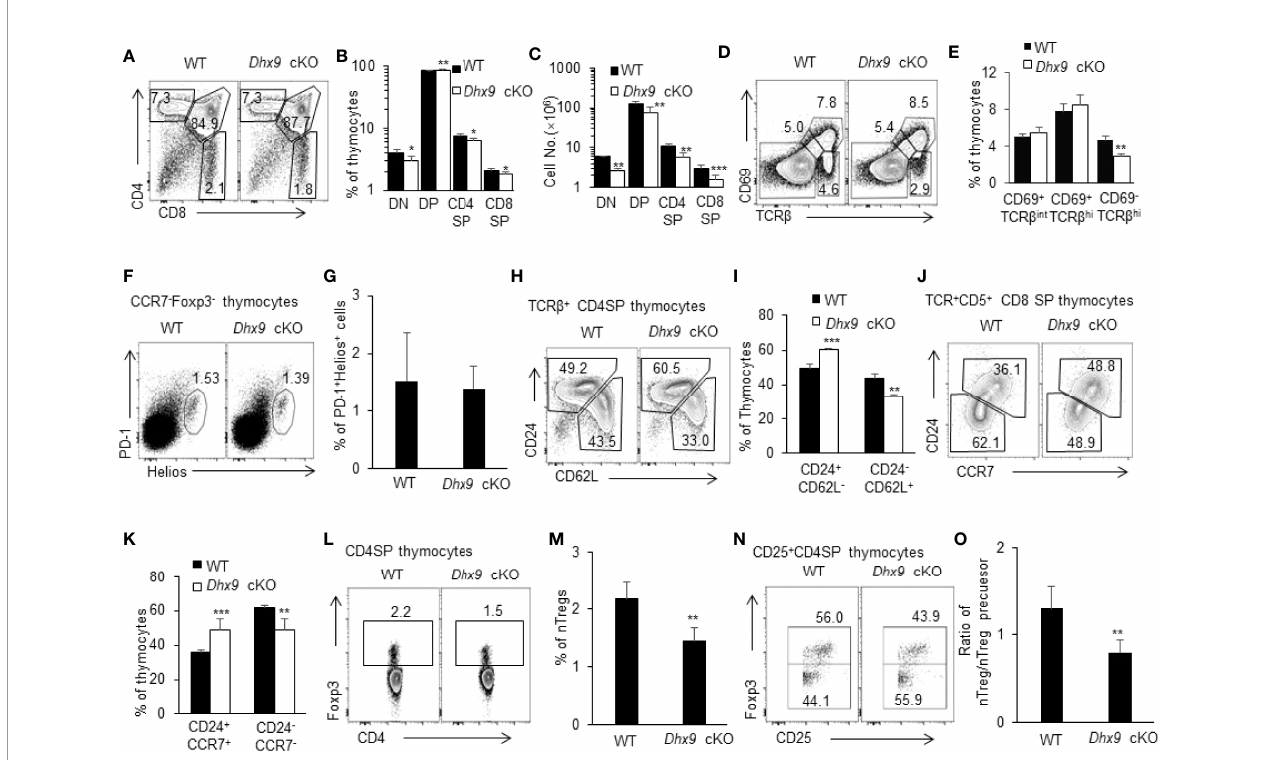
FIGURE 2 | Dhx9 deletion in TECs hindered the development of thymocytes. (A) Representative fl ow cytometry plots for DN (CD4 - CD8 - ), DP (CD4 + CD8 + ), CD4SP (CD4 + CD8 - ), and CD8SP (CD4 - CD8 + ) populations in the thymus from 4-week-old WT and Dhx9 cKO mice. (B, C) Frequencies (B) and cell numbers (C) of DN, DP, CD4SP, and CD8SP thymocytes of 4-week-old WT and Dhx9 cKO mice. (D, E) Representative fl ow cytometry plots and frequencies (E) of CD69 and TCR b -chain expressed on total thymocytes from 4-week-old WT and Dhx9 cKO mice. (F, G) Representative fl ow cytometry plots and frequencies (G) of Helios + PD-1 + thymocytes gated on TCR b + CD25 - CD4SP of 4-week-old WT and Dhx9 cKO mice. (H, I) Representative fl ow cytometry plots and frequencies (I) of post-selection maturation measured by CD24 and CD62L expression in TCR b hi CD4 + CD8 - thymocytes from 4-week-old WT and Dhx9 cKO mice. (J, K) Representative fl ow cytometry plots and frequencies (K) of post-selection maturation, as measured by CD24 and CCR7 expression in TCR b hi CD5 + CD4 - CD8 + thymocytes from 4-week-old WT and Dhx9 cKO mice. (L, M) Foxp3 expression by CD4 + CD8 − TCR + thymocytes in 4-week-old WT and Dhx9 cKO mice. (N) Representative fl ow cytometry plots showed the expression of Foxp3 on CD4 + CD8 - CD25 + thymocytes. (O) The histogram represented the ratio of nTreg (CD4 + CD8 - CD25 + Foxp3 + ) to nTreg precursors (CD4 + CD8 - CD25 + Foxp3 - ) for WT and Dhx9 cKO mice. One representative histogram represented the mean ± SD and WT = 5, Dhx9 cKO = 5 for each experiment. The unpaired, two-tailed student ’ s t -test was used. * P < 0.05, ** P < 0.01, *** P < 0.001 compared with WT control